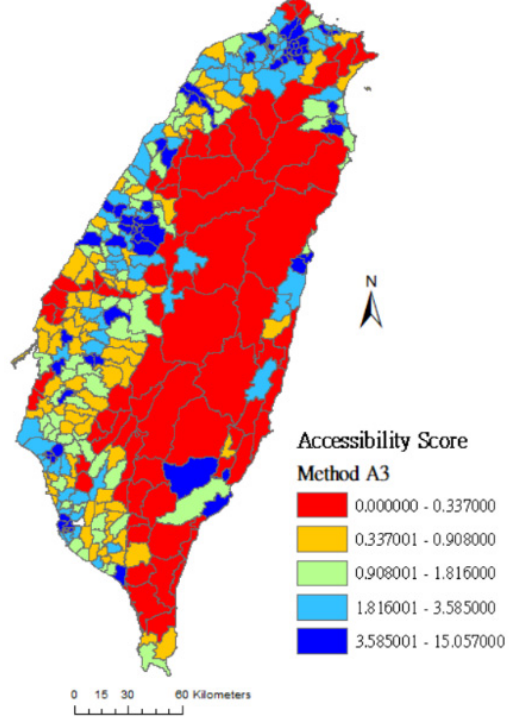
Figure 5. Accessibility score of rehabilitation physician service in Taiwan using method